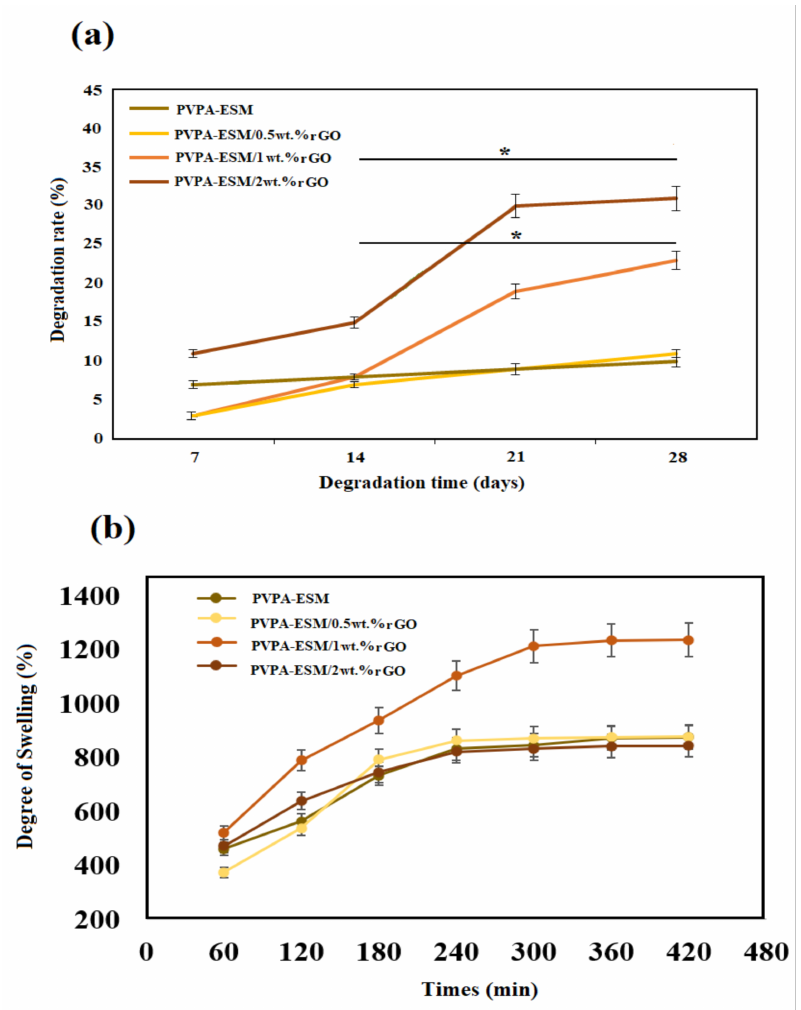
Figure 8. ( a ) Degradation rate and ( b ) degree of swelling of the electrospun PVPA–ESM and PVPA–ESM/x wt.% rGO nanofibers with various amount of rGO nanosheets (x = 0, 0.5, 1 and 2 wt.%) as a function of the soaking time ( p * <